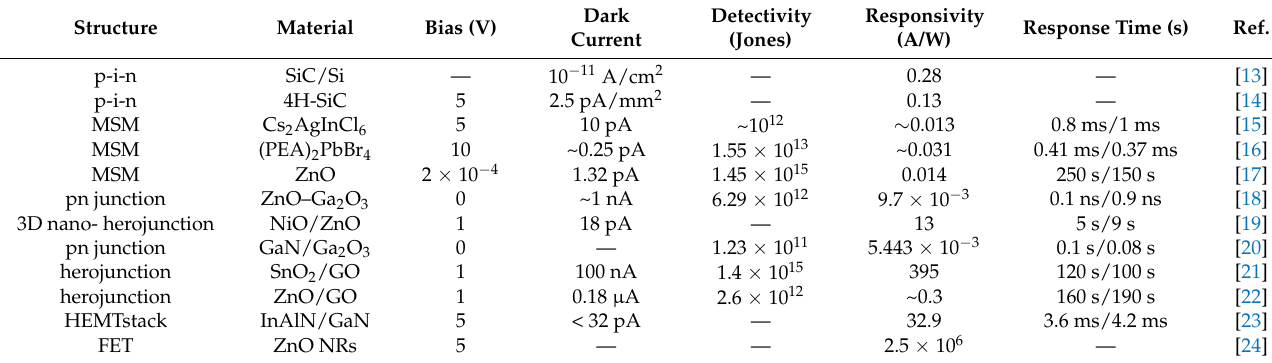
Table 1. The parameters of UV photodetector prepared by different materials.